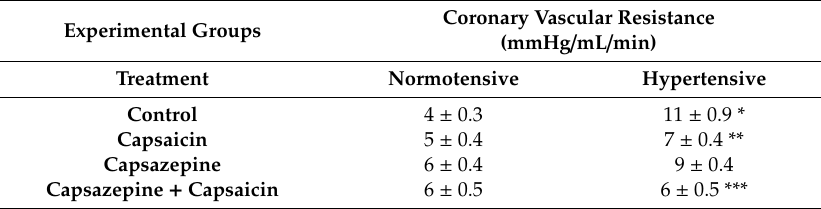
Table 2. E ff ect of capsaicin and capsazepine on coronary vascular resistance in normotensive and hypertensive